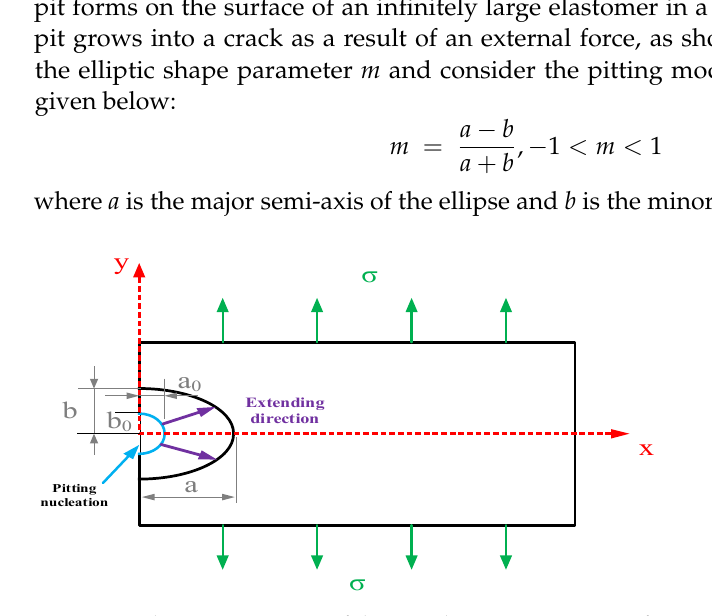
Figure 4. Schematic Diagram of the Development Direction of Pitting Corrosion.